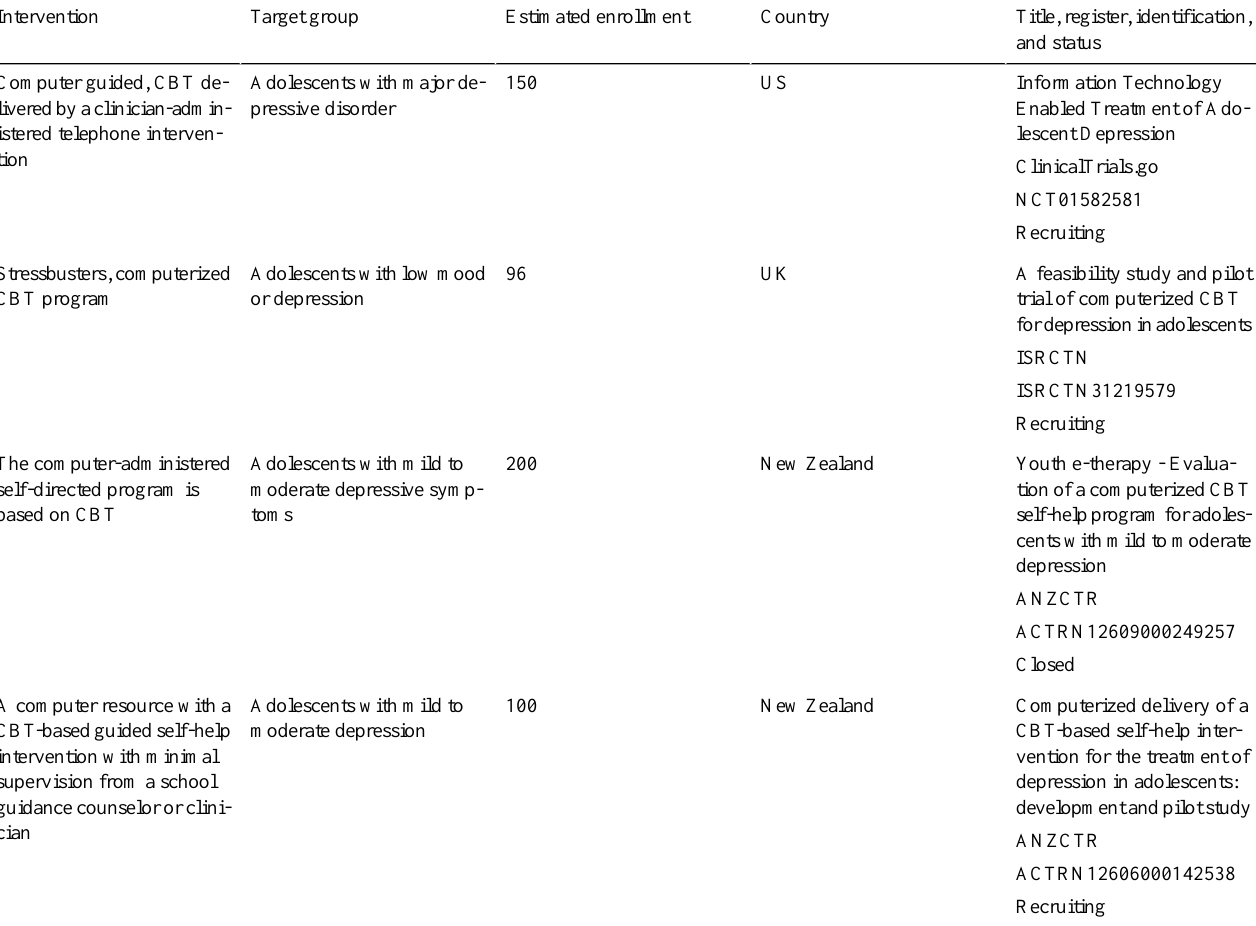
Table 1. Description of the registered randomized controlled trials considering the use of information and communication technology among adolescents with